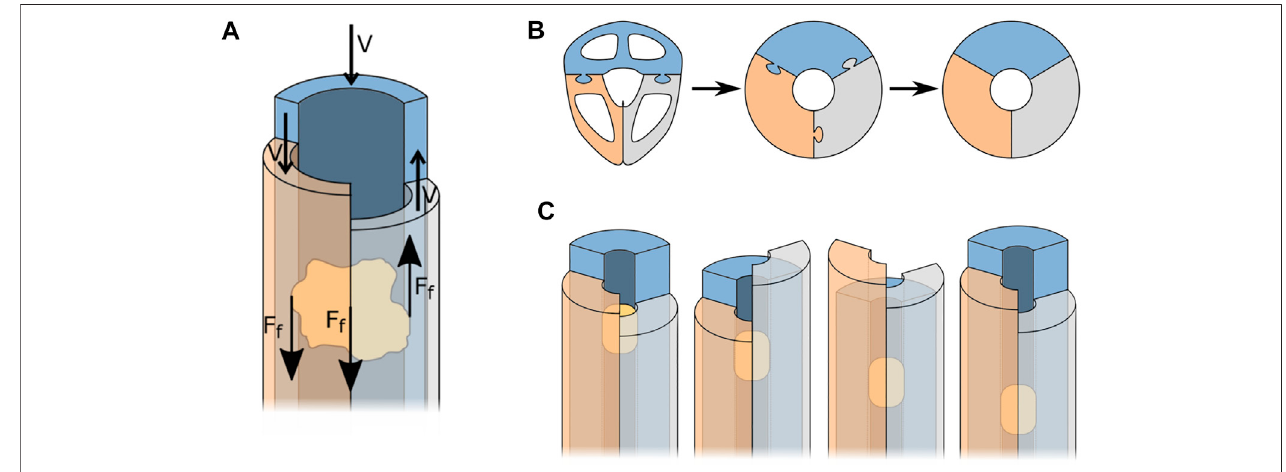
FIGURE 3 | Simpli fi cation of the wasp ovipositor to three semi-circular blades that form a tube. (A) Forces acting during friction-based transport. (B) Simpli fi cation process of the ovipositor. (C) Friction-based transport, for explanation see text.